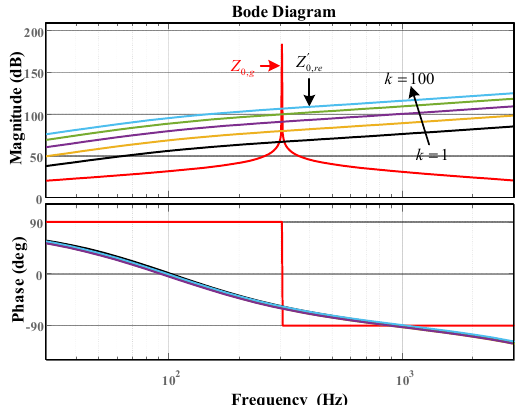
sequence system as an example.